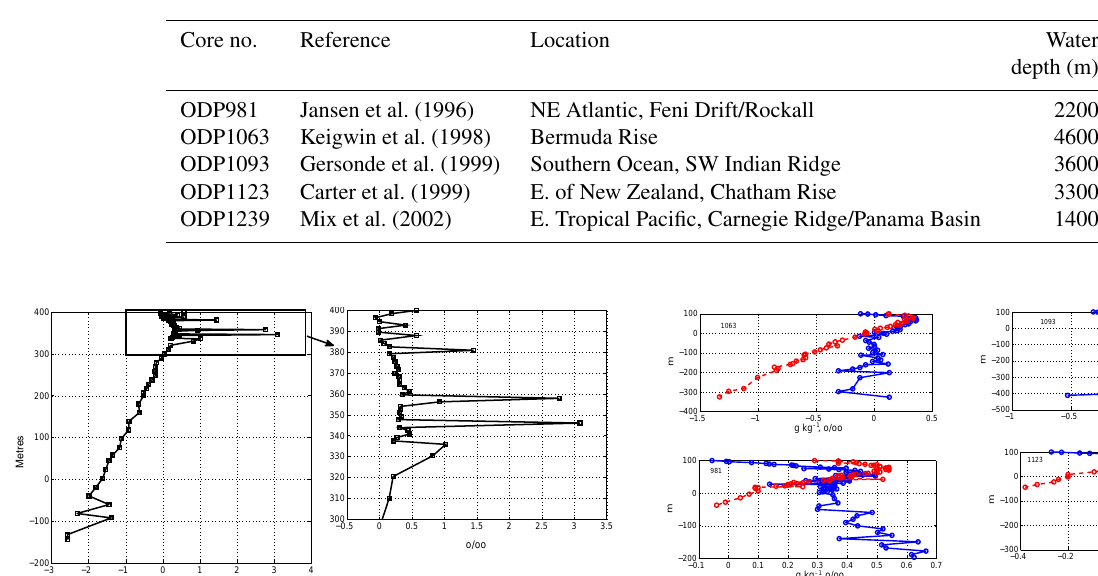
Figure 4. δ 18 O in core 1239, eastern equatorial Pacific, showing apparent undersampling near the core top and likely related to the intense dynamical variations expected on the equator and continen- tal margins. These data were not further used here. Position of zero in depth is arbitrary.